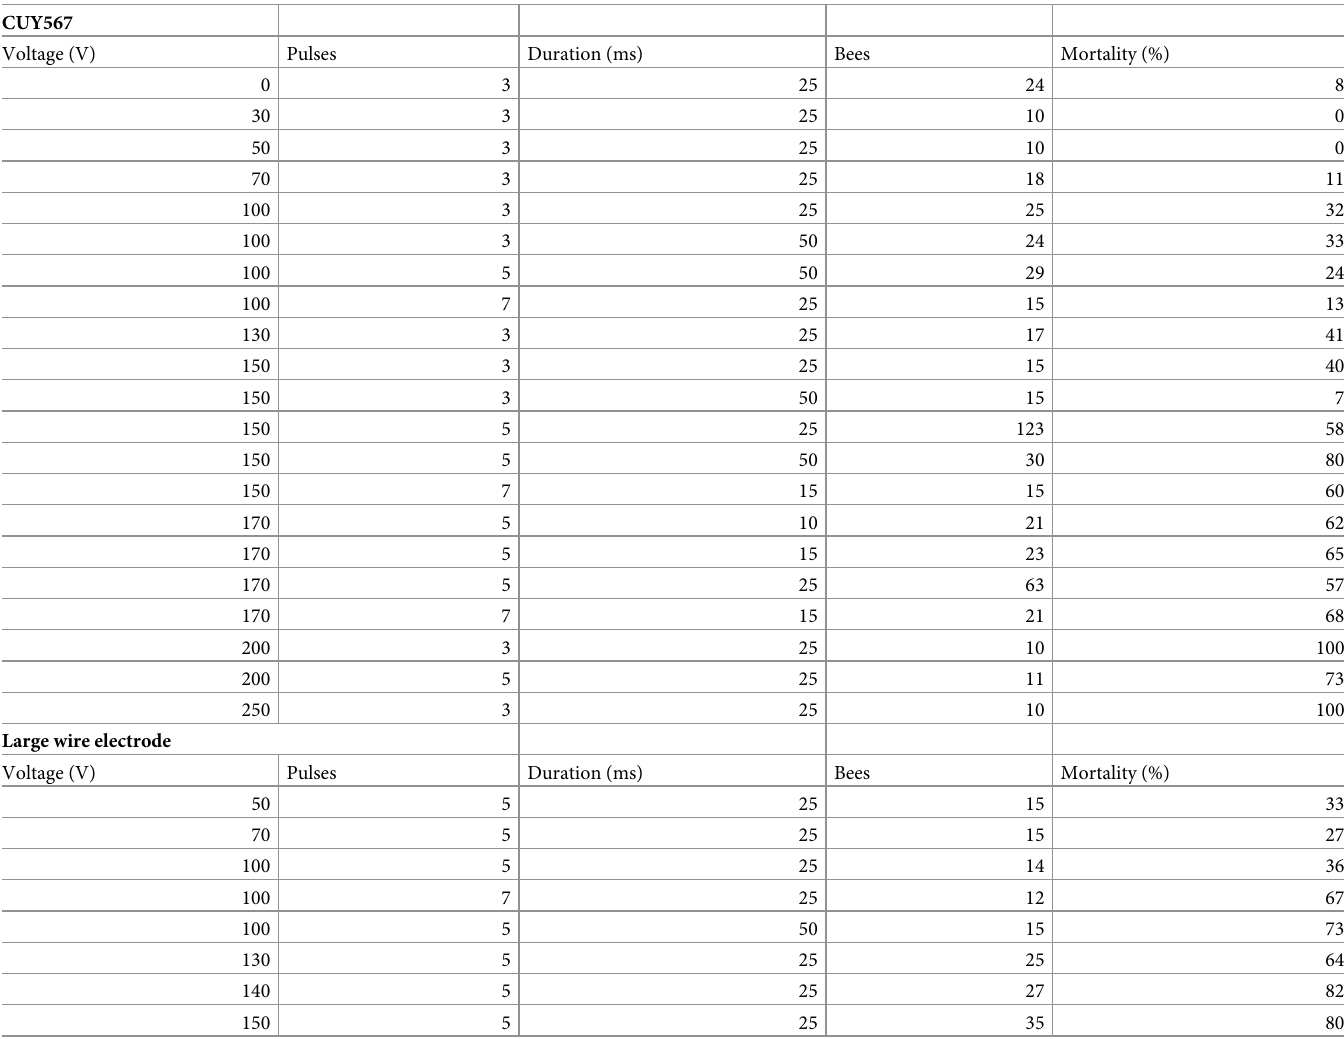
Table 1. Mortality induced with the CUY567 and the large wire electrodes by varying the number of pulses, pulse duration and voltage one day after the electroporation. CUY567 Voltage (V)